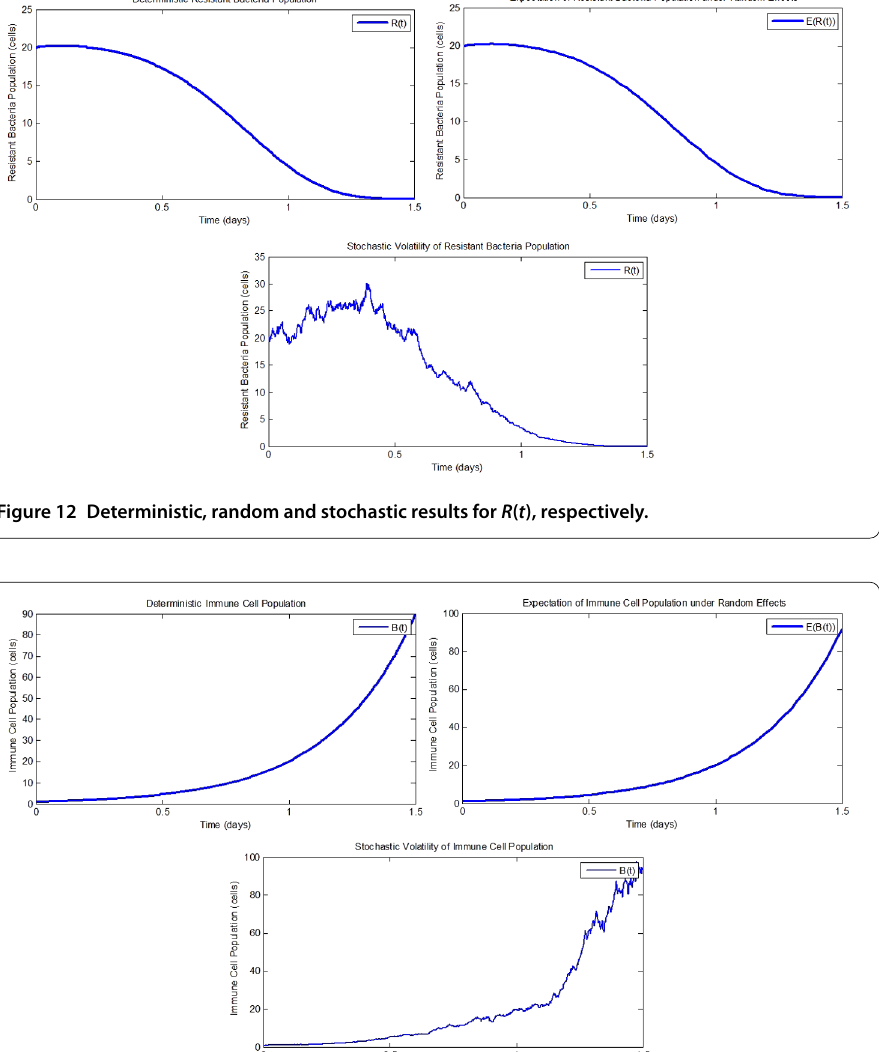
Figure 13 Deterministic, random and stochastic results for B ( t ),